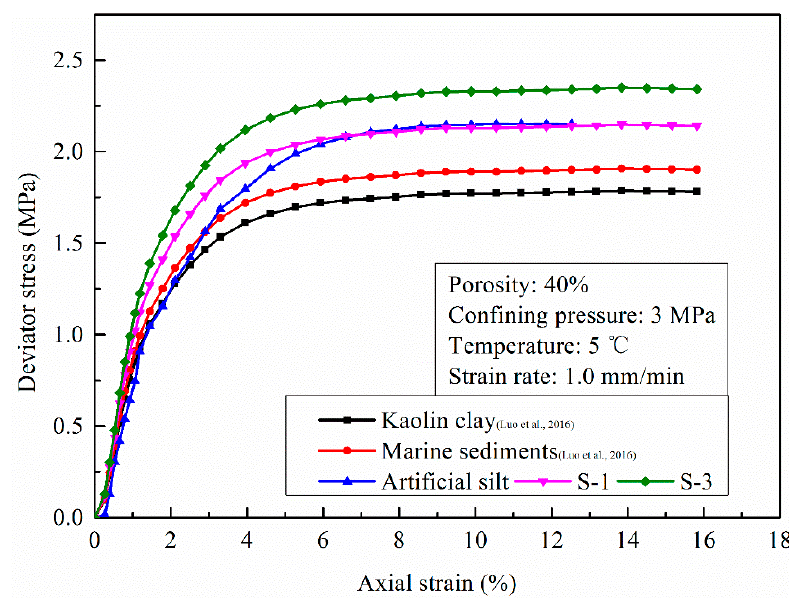
Figure 7. Stress – strain curves of HBMS, hydrate-bearing artificial silt and hydrate-bearing kaolin clay.